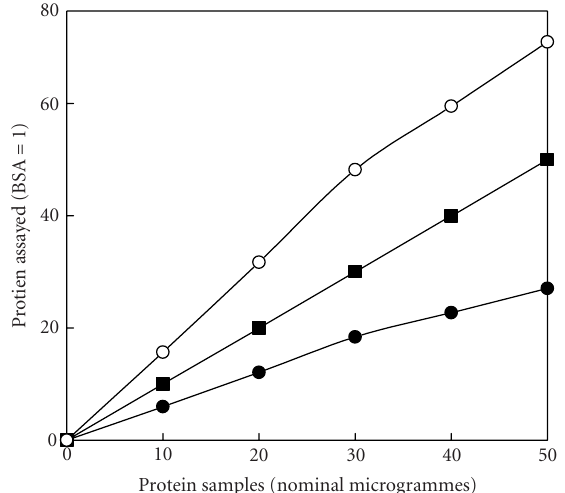
(Figure 8) that does not contribute to the protein